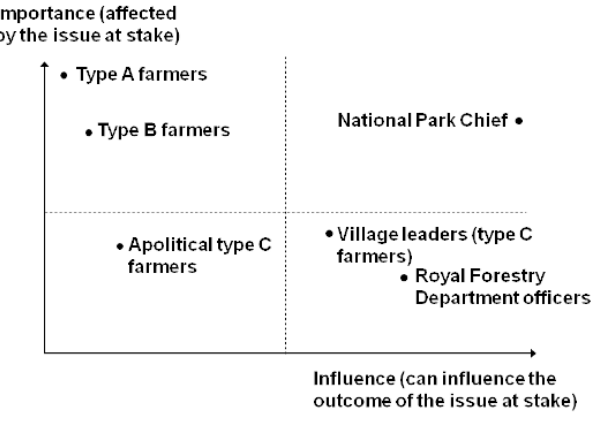
Fig. 2 . Matrix showing the key stakeholders’ relative influence and importance in the national park issue, Nan Province,